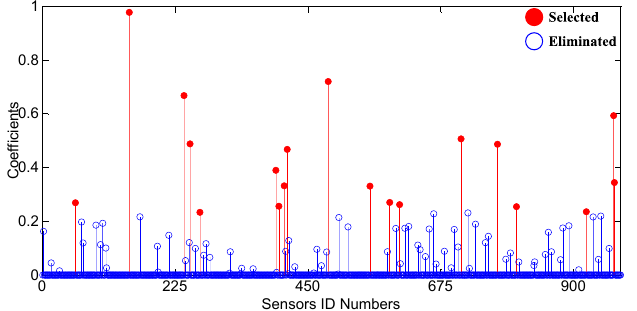
Figure 2. The indicator vector of the layout experiment on the irregular square scene without critical regions. The red dots denote the adopted cameras with large coefficients.